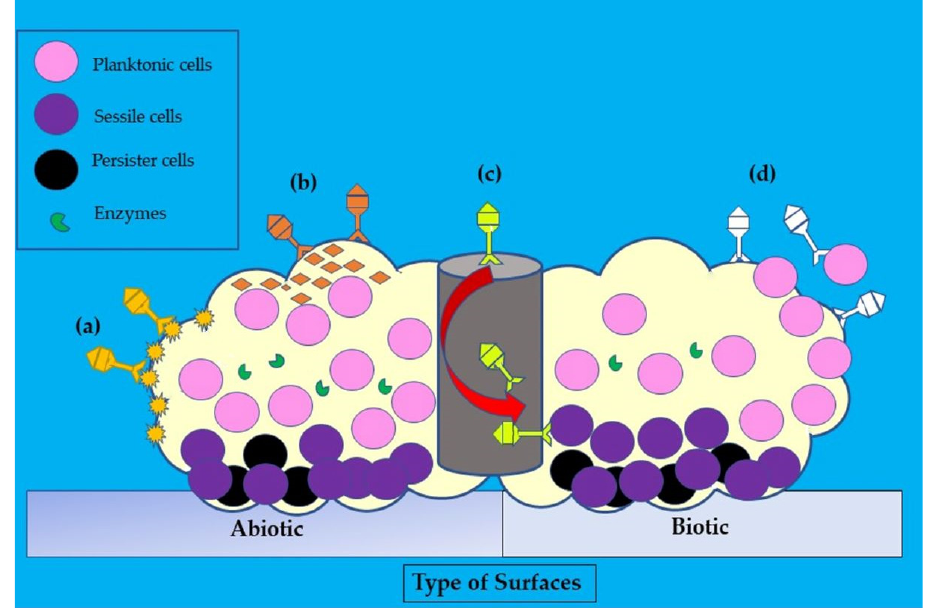
Figure 5. Illustration of the disruptive mechanisms of bacteriophages in Staphylococcus aureus biofilms on abiotic and biotic surfaces by the ( a ) expression of polysaccharide depolymerases which degrade extracellular matrix, ( b ) induction of host cells to produce exopolysaccharides (EPS)-degrading enzymes, ( c ) diffusion via biofilm water channels for inner layer penetration, and ( d ) adsorption to bacteria for biofilm penetration. The role of each bacteriophage is depicted in various colors (dark yellow, orange, yellow, and white).